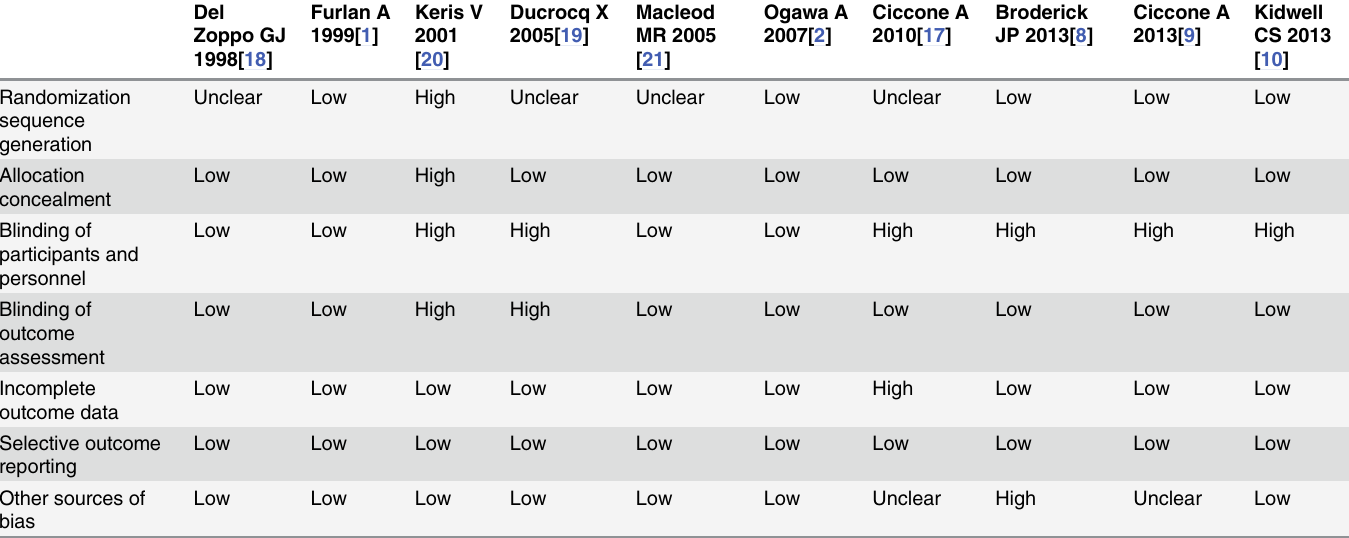
Table 2. Cochrane assessment of bias risk of randomized controlled